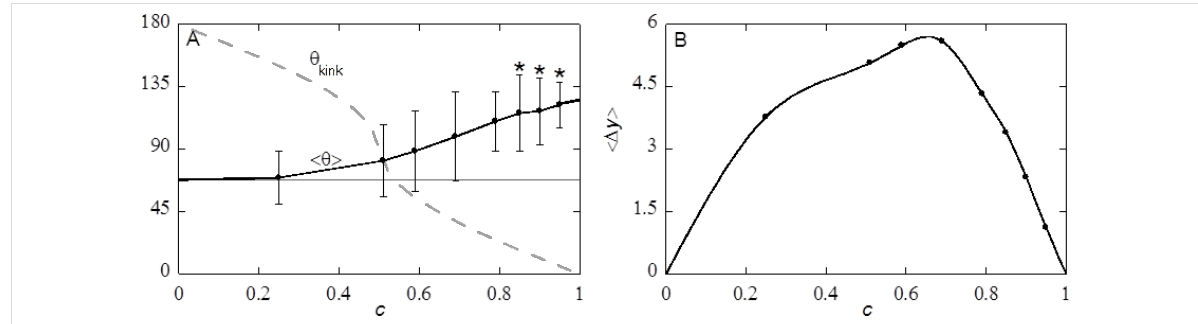
Figure 14: A) The advancing contact angle and standard deviation as function of cut-off fraction c for fixed value of the solid fraction in the top- layer of the substrate Φ S = 0.43. The grey line is θ Y on a smooth surface and the grey dashed line is the angle of the kink at different c . Stars indicate that the cavity under the liquid front are vapour-filled (Cassie–Baxter wetting state). B) Variation in y -position as function of cut-off fraction c for d = 39 and χ S = −